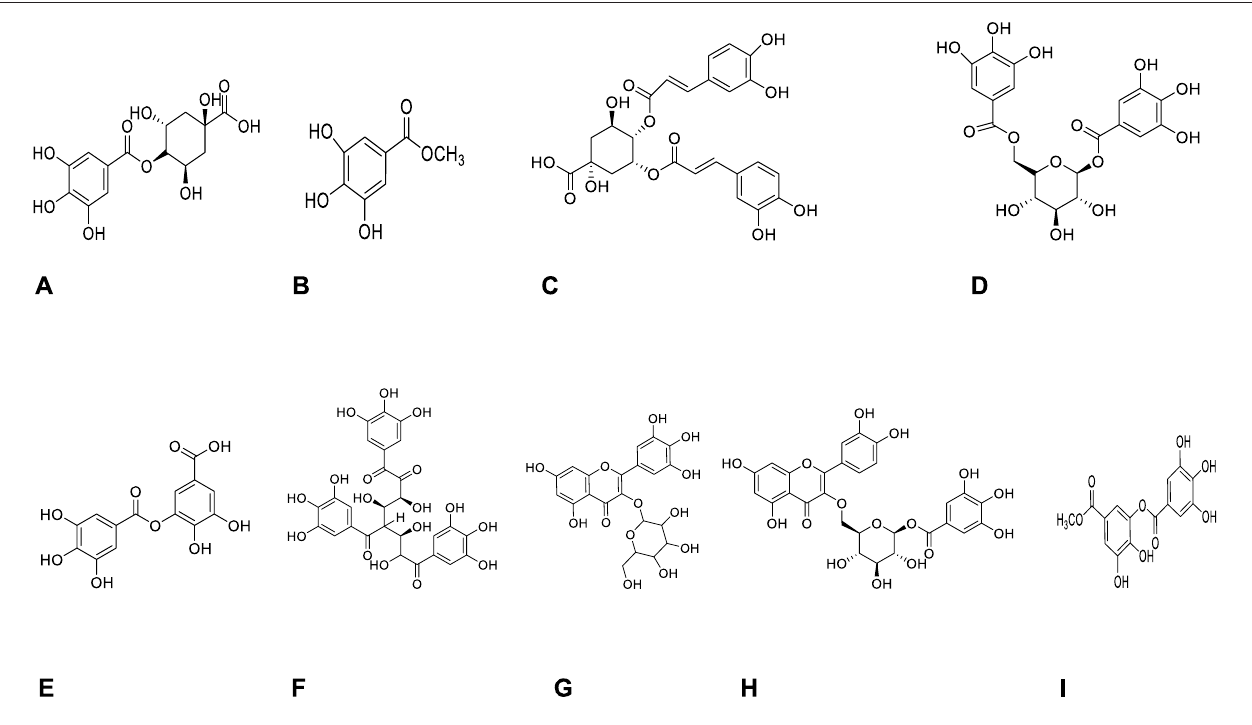
FIGURE 4 | Molecules detected in the G coded sub-fraction by LC-QTOF-MS analysis (A) : Galloylquinic acid; (B) : Methyl gallate; (C) : Digalloylquinic acid; (D) : Digalloylglucose; (E) : Digallic acid; (F) : Trigalloylglucose; (G) : Myricetin-3-O-hexoside; (H) : 2 ″ -O-galloyl-quercetin-3-O-hexoside; (I) : Methyl digallate.